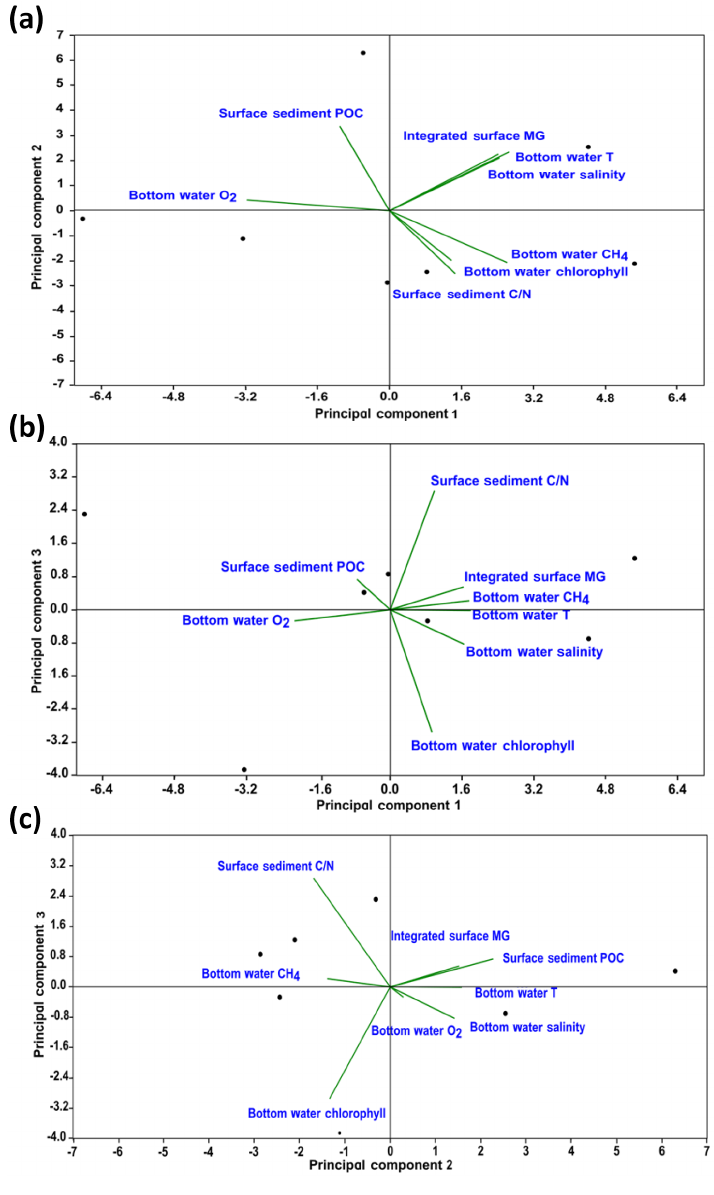
Figure 10. Principal component analysis (PCA) from three different angles of integrated surface methanogenesis (0–5cmb.s.f.) and surface particulate organic carbon averaged over 0–5cmb.s.f. (surface sediment POC), surface C / N ratio averaged over 0–5cmb.s.f. (surface sediment C / N), bottom water salinity, bottom water temperature ( T ), bottom water methane (CH 4 ) , bottom water oxygen (O 2 ) , and bottom water chlorophyll. Data were transformed into ranks before analysis. (a) Correlation biplot of principal components 1 and 2, (b) correlation biplot of principal components 1 and 3, and (c) correlation biplot of principal components 2 and 3. Correlation biplots are shown in a multidimensional space with parameters shown as green lines and samples shown as black dots. Parameters pointing in the same direction are positively related; parameters pointing in the opposite direction are negatively